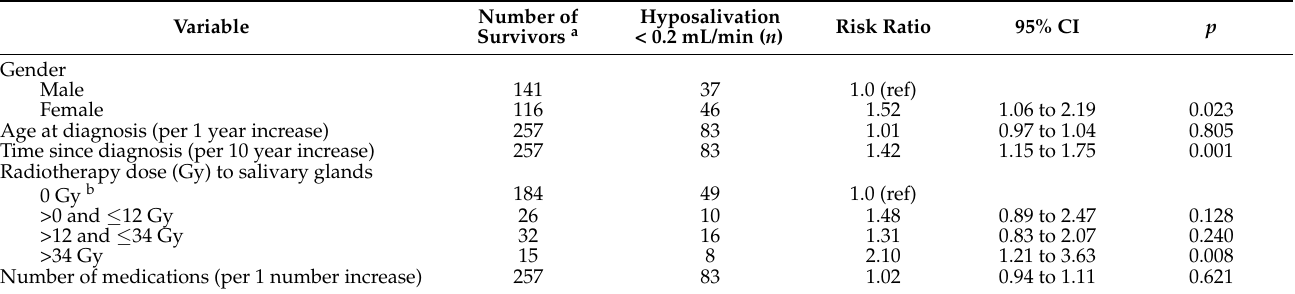
Table 5. Poisson regression analysis for hyposalivation, measured by unstimulated whole salivary flow rates in childhood cancer survivors ( n = 257).